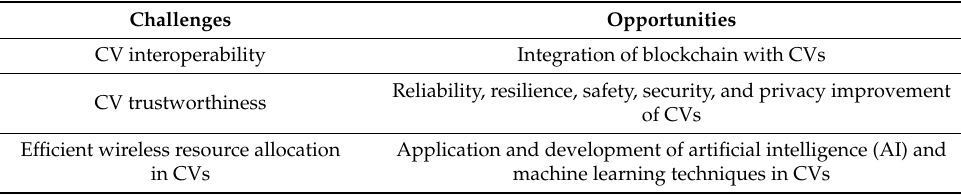
Table 4. Summary of challenges and opportunities of application of CVs in EVs